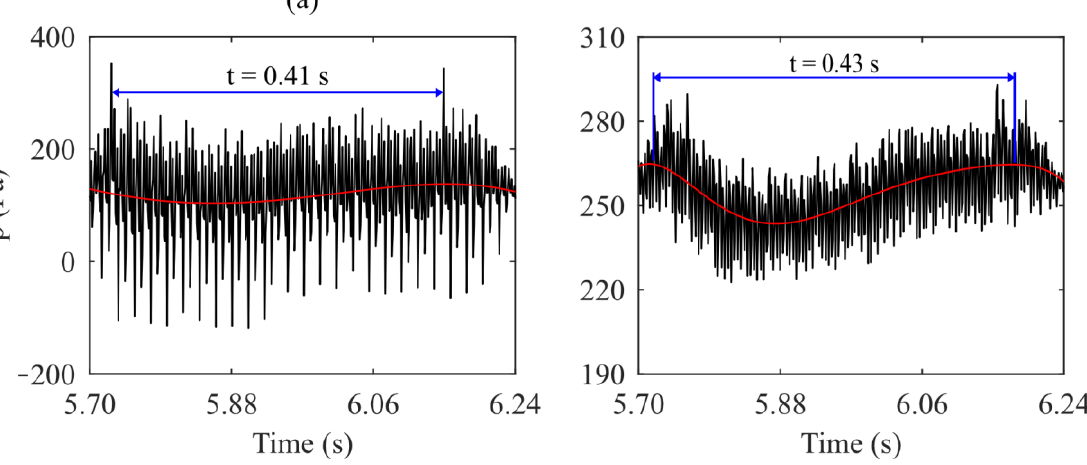
Figure 13. The time history of the pressure 𝑝 in the monitor points, ( a ) P1 and ( b ) P2. The red lines are curve fits to the instantaneous pressure.